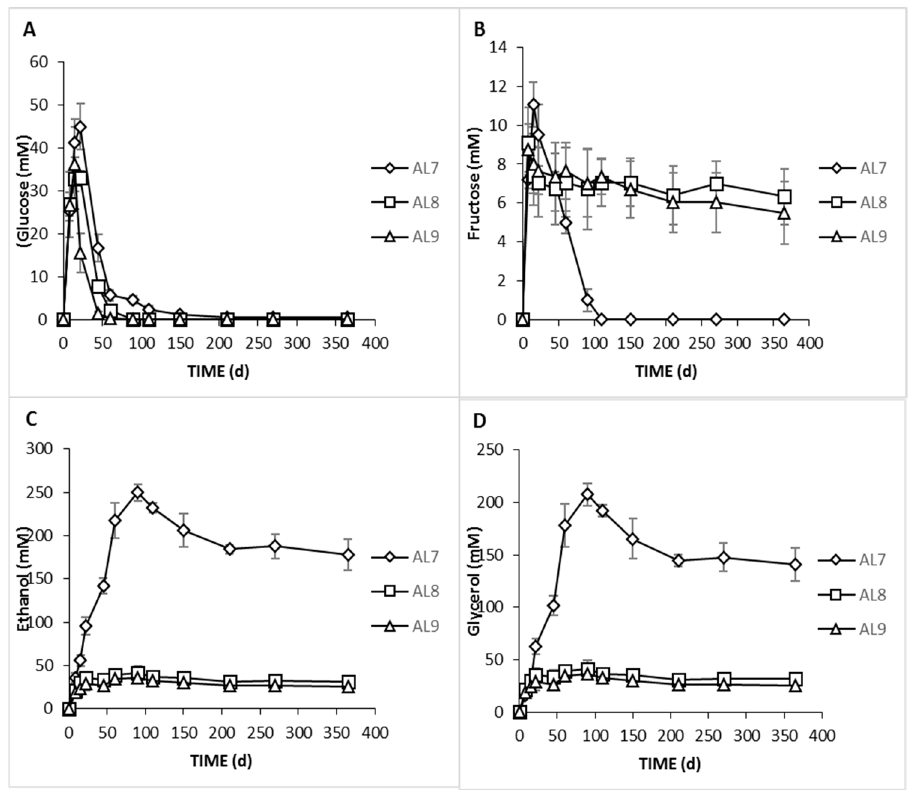
Figure 6. Changes in the concentration (mM) of soluble sugars (glucose, A ; fructose, B ) and alcohols (ethanol, C ; glycerol, D ) in the brines during processing of Cypriot green cracked table olives of Spontaneous ( ◊ ), inoculated (10% NaCl) ( □ ), and inoculated (7% NaCl) ( ∆ ) fermentations. Data points are expressed as means and standard deviations in triplicate.